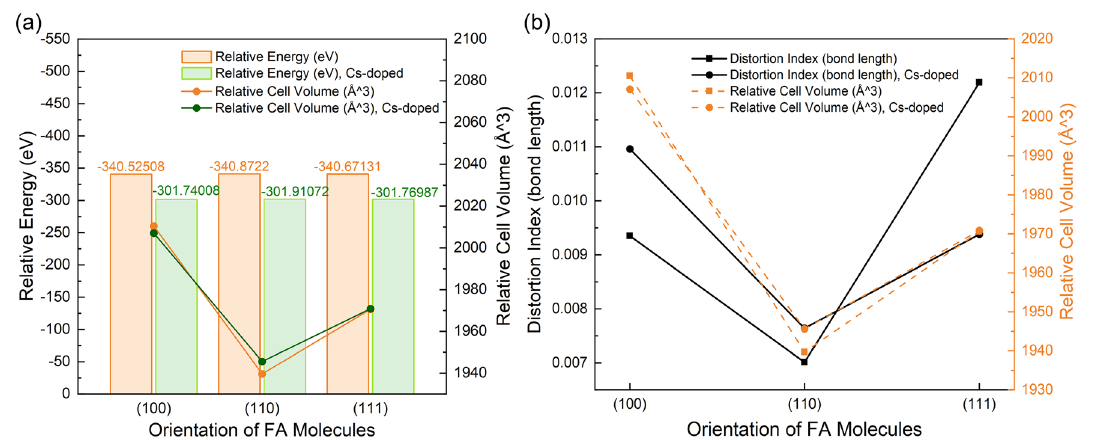
Figure 2. ( a ) Relative energy and relative cell volume in different FA cations orientation; ( b ) relative energy and distortion index (bond length) in different FA cations